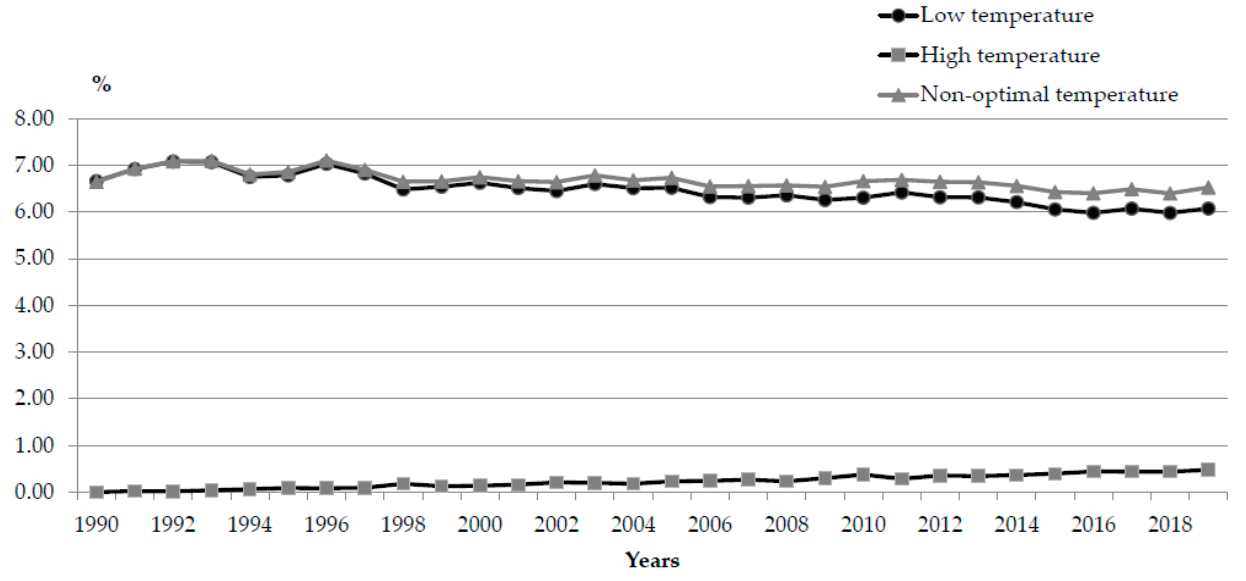
Figure 1. The contribution (%) of non-optimal temperature to global ischemic heart disease mortality in both sexes together, 1990–2019.